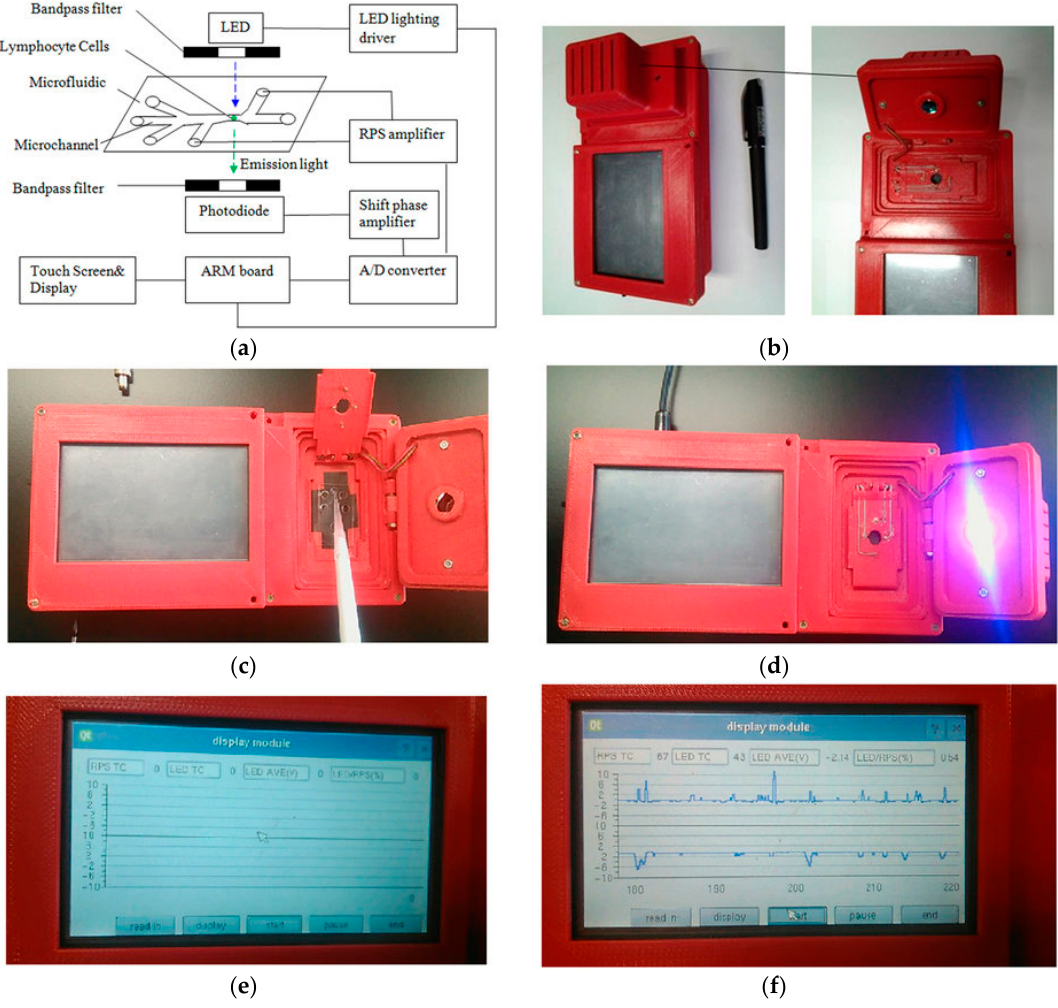
Figure 3. Handheld flow cytometer produced by Wang et al. (Scientific Reports, 6(2016) [56]), with miniaturized optical detectors, a disposable microfluidic analysis chip, and electronic display readouts. ( a ) schematic diagram; ( b ) device housing with space for microfluidic chip; ( c ) pipetting sample onto microfluidic chip; ( d ) UV LED active; ( e ) electronic display module; ( f ) electronic readout of sample electrophoretic data.